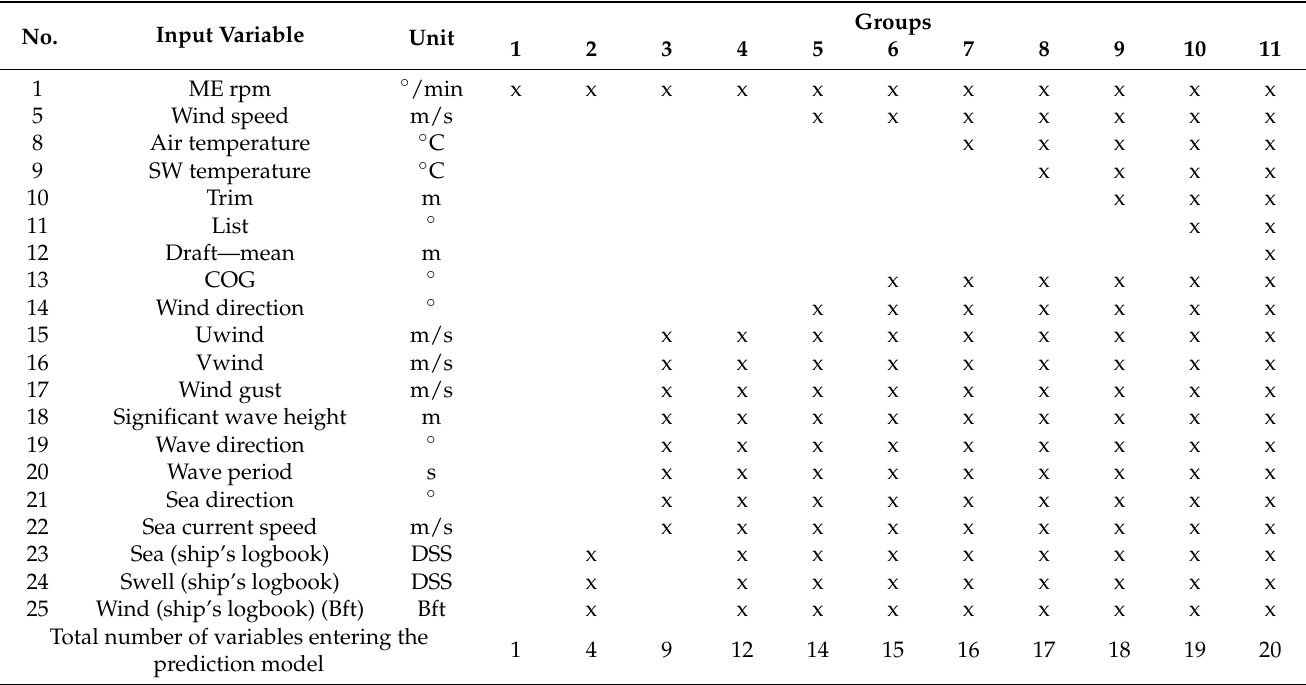
Table 6. List of input variables with combinations in which they enter the prediction model.